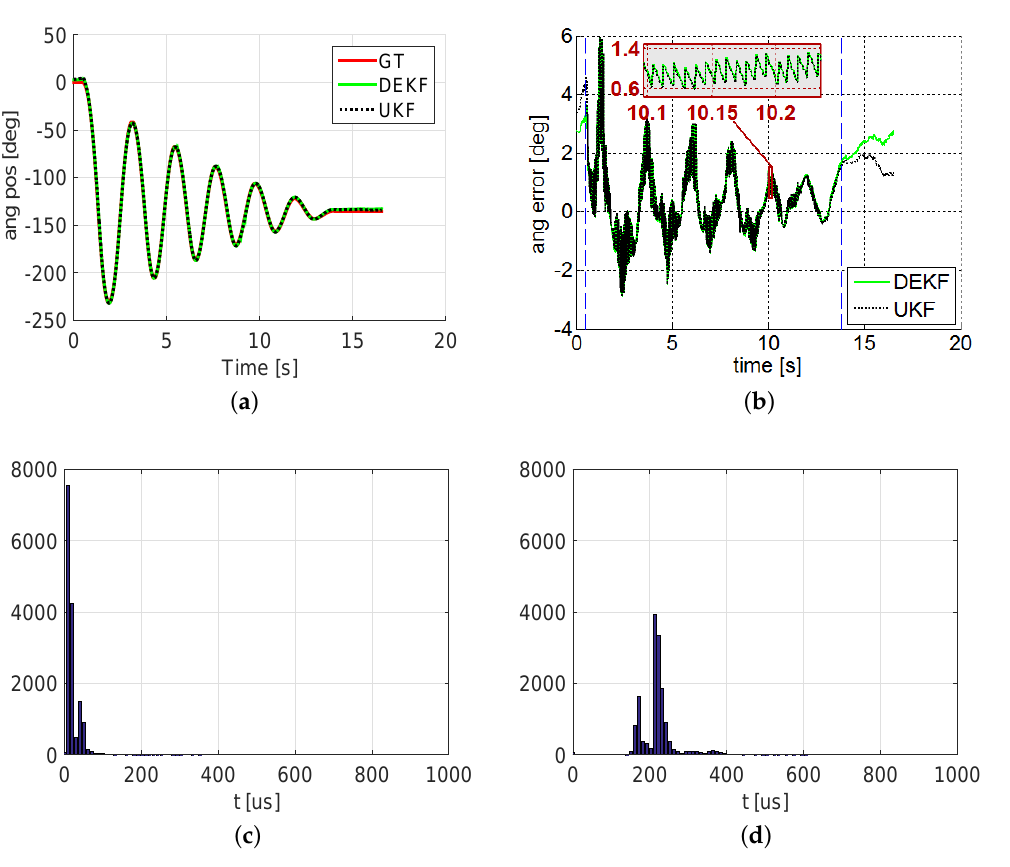
Figure 7. Results of the dynamic experiment: ( a ) Crank angle measured by the encoder and estimated by the Discrete Extended Kalman Filter (DEKF) and the unscented Kalman filter (UKF); ( b ) Estimation error of the crank angle; ( c , d ) Histogram of the computational cost of each filter. Due to the usage of non real-time operative systems, each timestep takes a different duration to complete. ( a ) Estimated and ground-truth crank angles; ( b ) Estimation error; ( c ) DEKF; ( d )